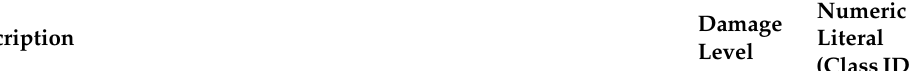
Table 2. Crack categorisation adopted from [29–31].